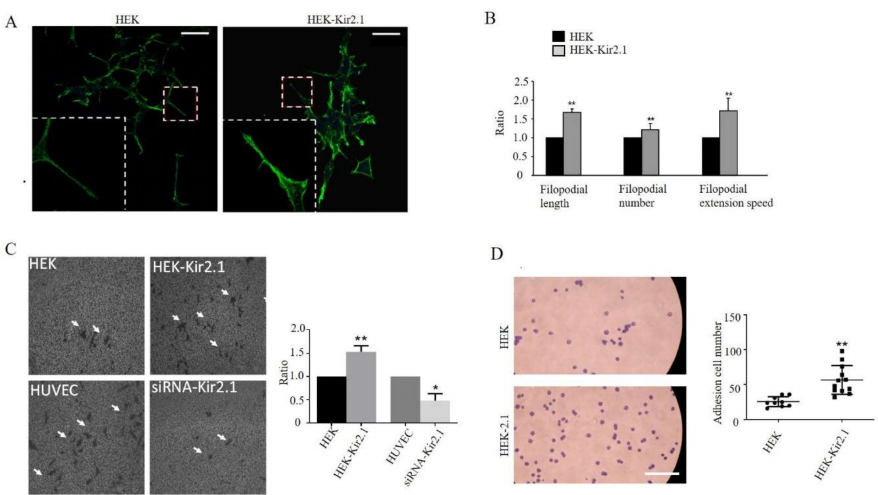
Figure 2. Kir2.1 promotes filopodial extension, cell migration, and cell adhesion. ( A ) F-actin was visualized by FITC-conjugated phalloidin staining in HEK and HEK-Kir2.1 cell lines. The white dotted frames show the magnified images. Scale bar: 100 µ m. ( B ) Quantification of filopodial length, filopodial number, and filopodial extension speed. ** p < 0.01. ( C ) Representative fields of the Transwell invasion assay under a phase-contrast microscope. Cells were grown, transfected, and then subjected to the Transwell assay. The white arrows point to the migrated cells stained by methylrosanilnium chloride solution. Quantitative results of the relative ratio of migrated cells is shown on the right; ** p < 0.01, * p < 0.05. ( D ) Representative fields of the adhesion assay. Cells were stained by methylrosanilnium chloride solution and measured by counting after adhesion for 45 min. scare bar: 500 µ m. Quantification of total adhesion cell number per random field is shown on the right; ** p <